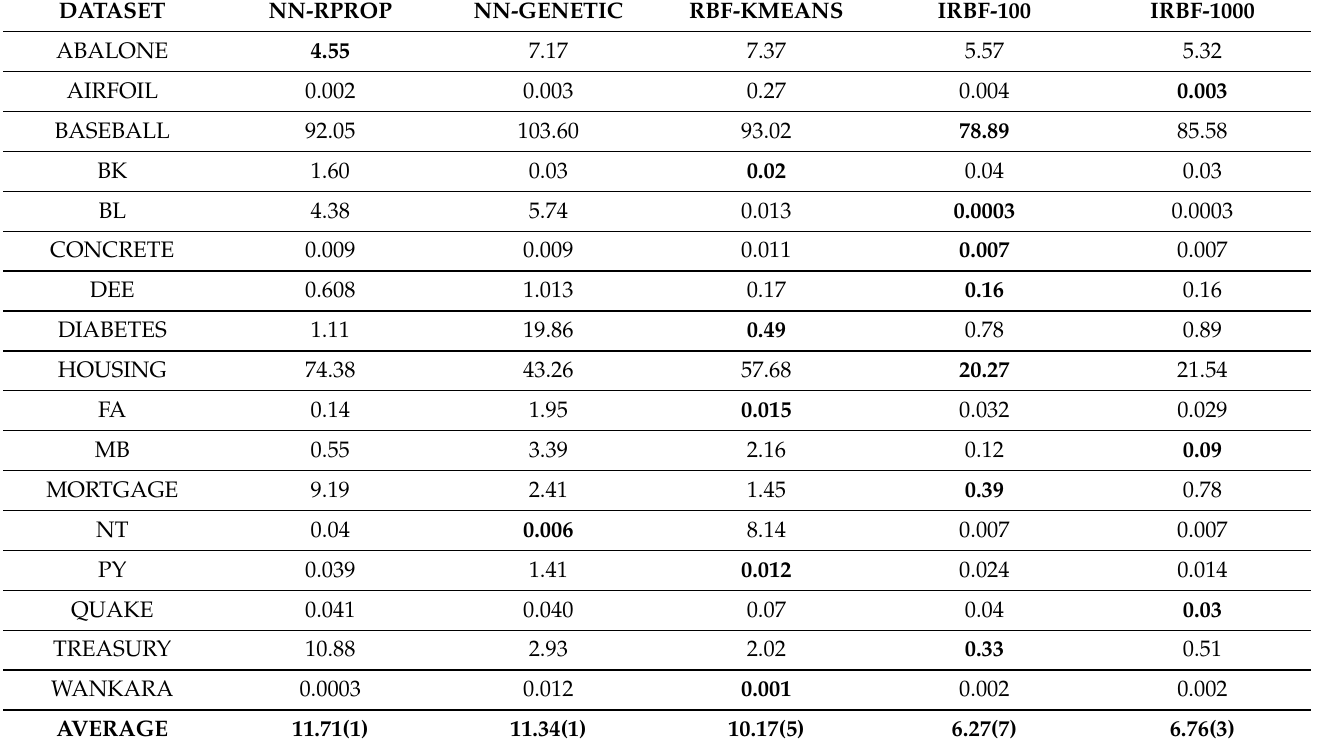
Table 3. Experimental results for the regression datasets. The first column is the name of the used regression